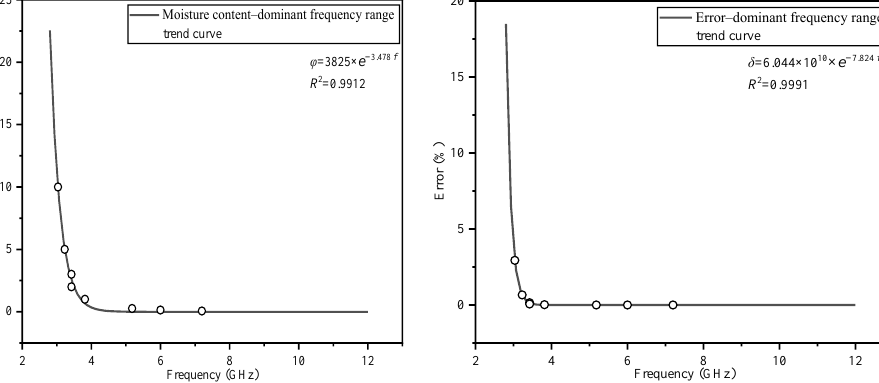
Figure 8. Trend graph of the imaginary part of the dielectric constant.